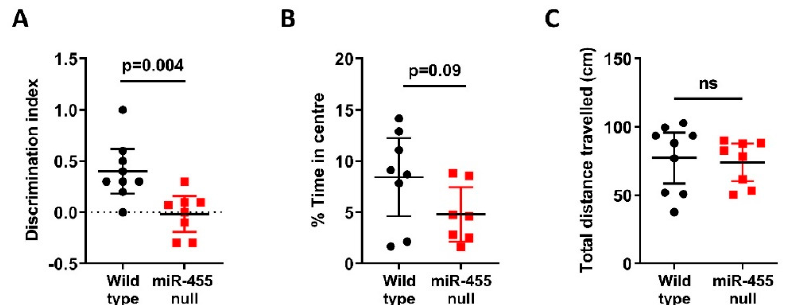
Figure 2. Behavioural studies comparing the miR-455 null mouse vs. wild-type. ( A ) 14-month-old miR-455 null ( n = 9) mice and wild type mice ( n = 8) were tested for recognition memory using the novel object recognition test (NOR); miR-455 null mice have significant recognition memory deficit as indicated by a decreased discrimination index. ( B ) Anxiety behaviour was tested using the open field test. MiR-455 null mice display an increase in anxiety with ( C ) no difference in overall locomotion. Bars show the mean ± SEM.